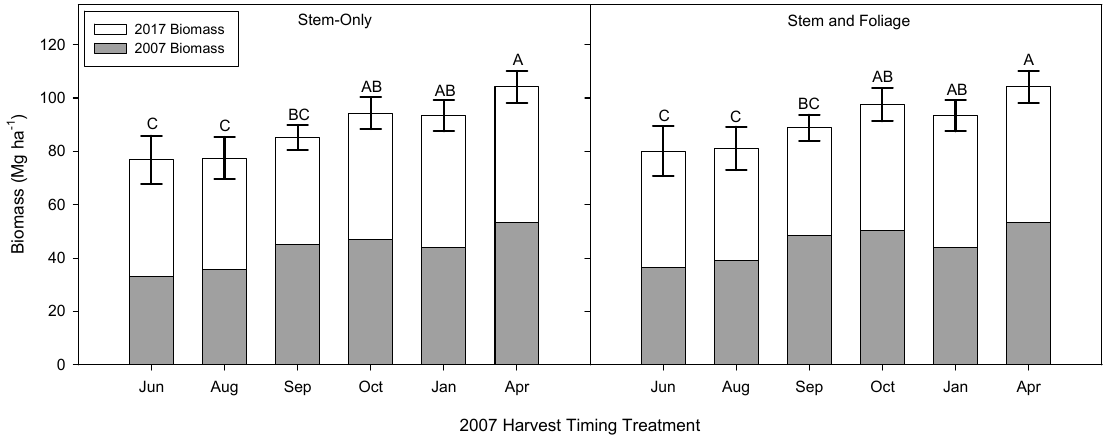
Figure 7. Combined biomass production (mean ± SE) for both 2007 and 2011 with and without foliage. Letters indicate significant differences within each graph only for combined biomass.